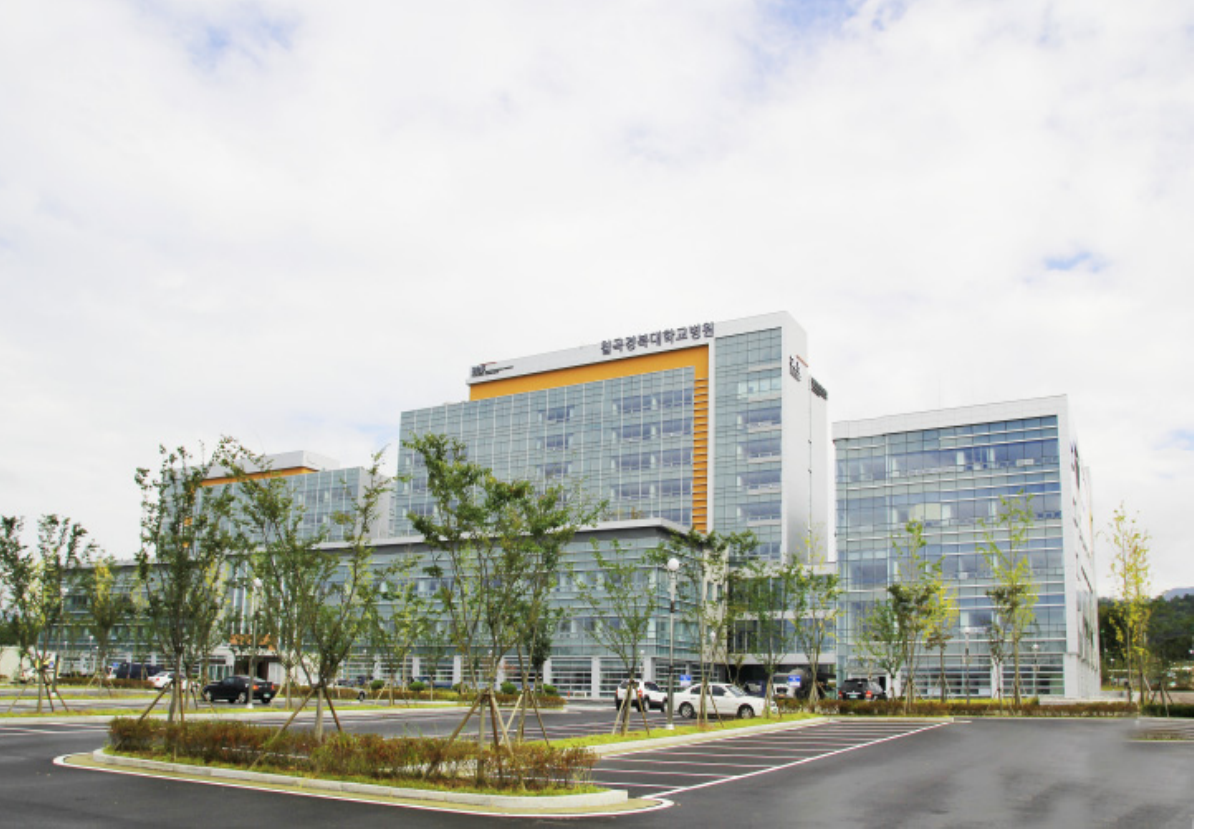
Figure 1. Exterior of the